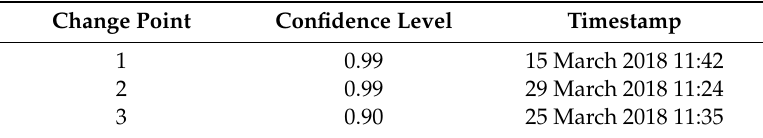
Table 6. The information of the change points for Turbine #38.